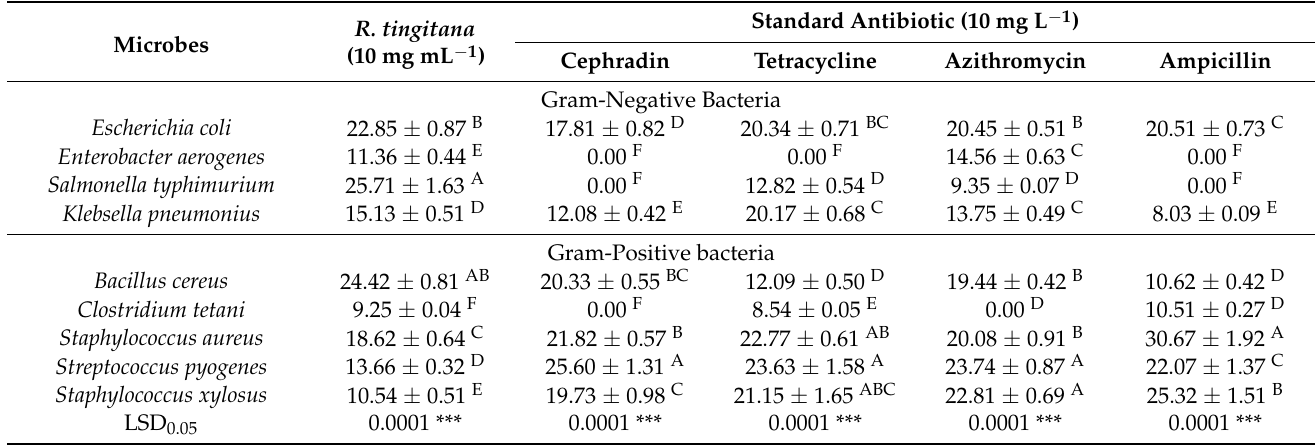
Table 3. Antibacterial activity of the methanol extract from the aerial parts of R. tingitana and some selected reference antibiotics at a concentration of 10 mg mL − 1